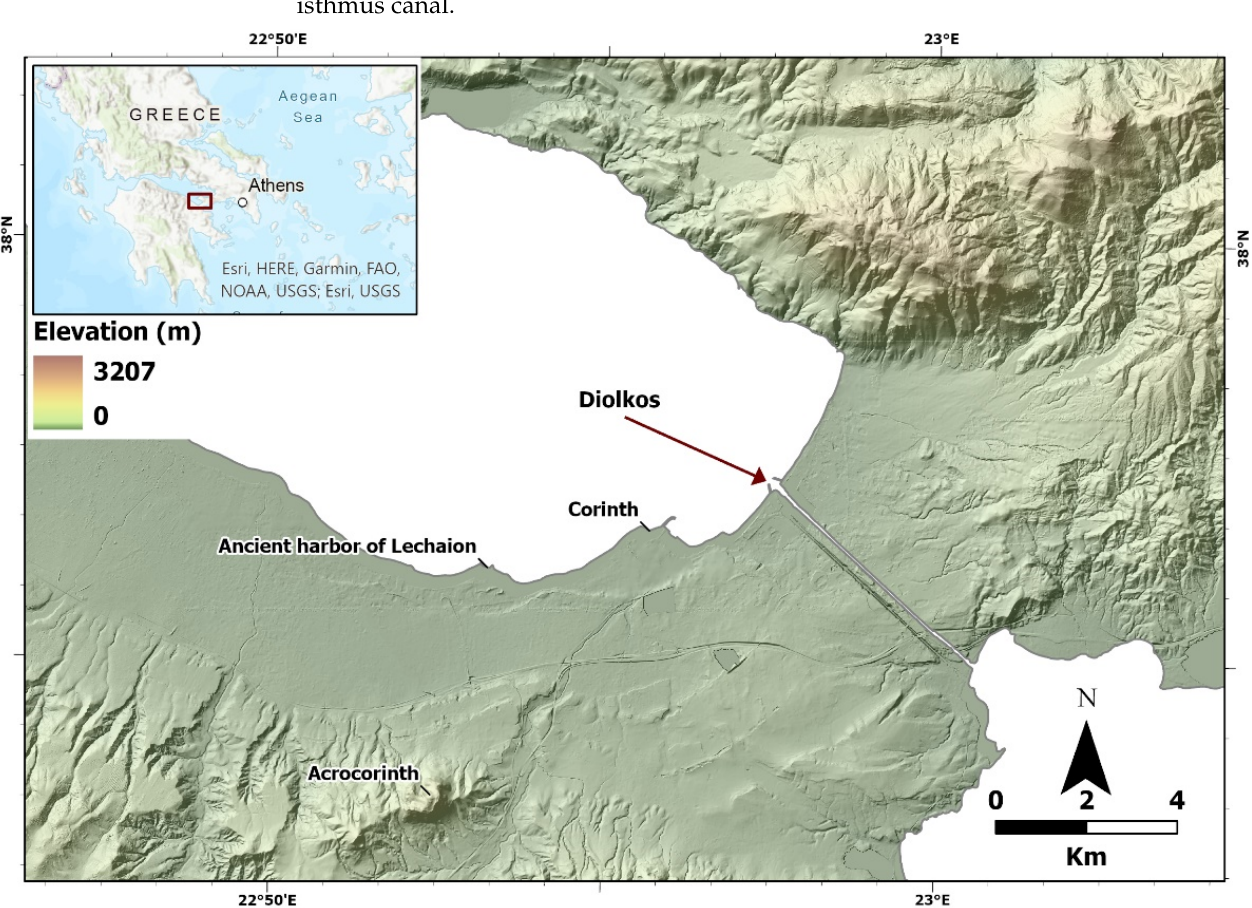
Figure 1. A morphological elevation map of the general area of Corinth. Corinth isthmus (canal) can be observed along with the modern town of Corinth, the Acrocorinth, and the ancient harbor of Lechaion.